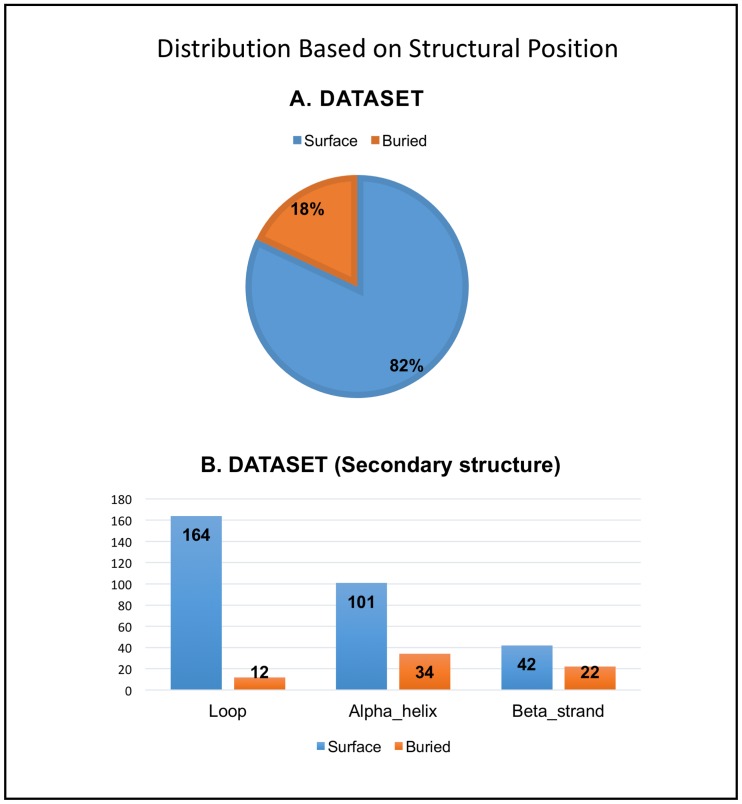
Distribution of SNVs based on structural position.A. Distribution of the SNVs in our benchmark dataset based on structural position (Piechart). There are two broad categories, Surface (residue) or Buried (residue). B. Distribution of the SNVs in the dataset based on secondary structural location (Bar graph). The two broad categories, Surface (residue) or Buried (residue) are further categorized into Loop, Alpha_helix and Beta_strand based on the secondary structural element to which the SNV maps.